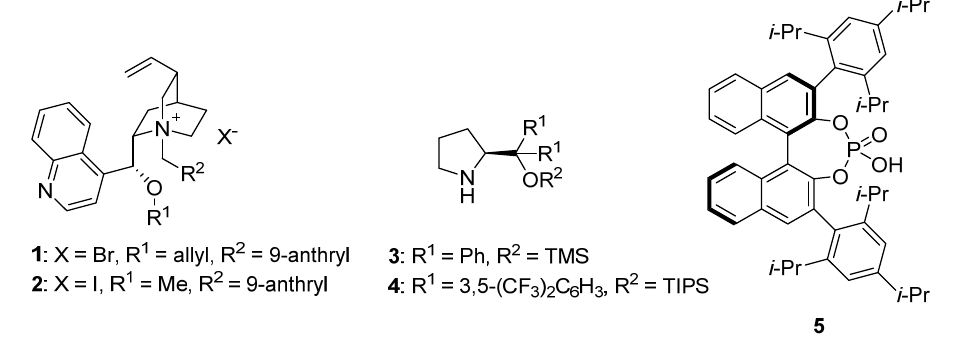
Figure 1. Chiral organocatalysts for α -allylation